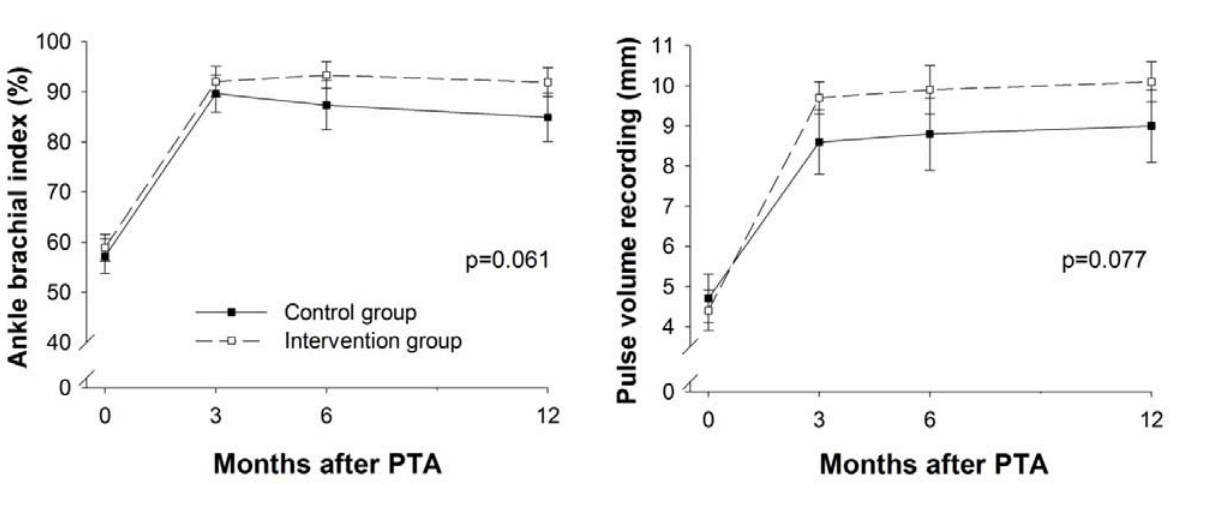
3. Limb hemodynamics. Values are mean, error bars indicate ±SEM. mm =